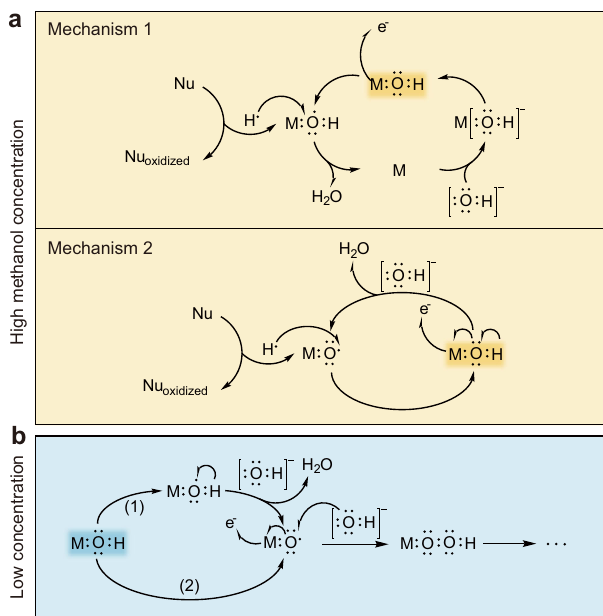
Fig.5|MechanismsofMOR.a Mechanismsofmethanoloxidationreactioninhigh methanol concentration case (Upper: Ni atom loses electrons and the reaction involves electrophilic OH*. Lower: OH* on the catalyst surface loses hydrogen atoms and the reaction involves electrophilic O*). b Mechanisms of methanol oxi- dationreactioninlowmethanolconcentrationcase((1)Niatomloseselectrons.(2) OH* loses hydrogen